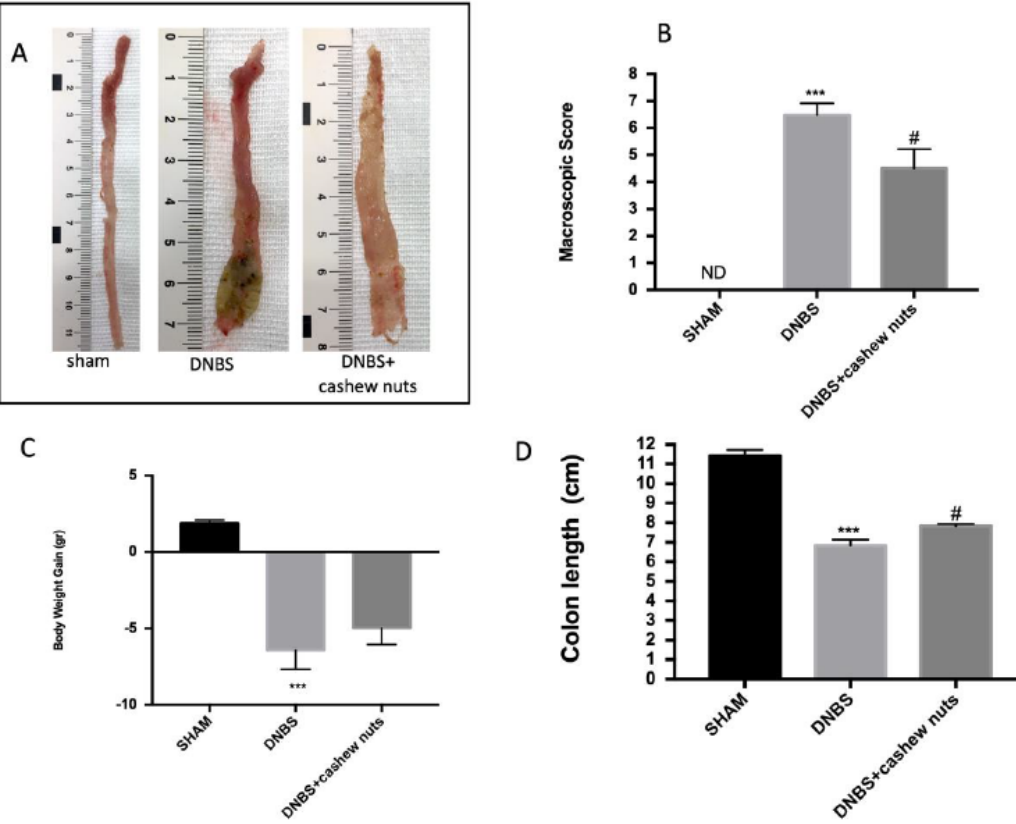
Figure 2. The e ff ects of cashew nuts on macroscopic damage, body weight increase, and colon length after dinitrobenzene sulfonic acid (DNBS) injection. Macroscopic damage in sham, DNBS, DNBS + cashew nuts groups ( A and B ). Body weight increase in all groups ( C ). Colon length ( D ). Values = means ± SEM of six animals in each group; *** p < 0.001 vs. sham; # p < 0.05 vs.